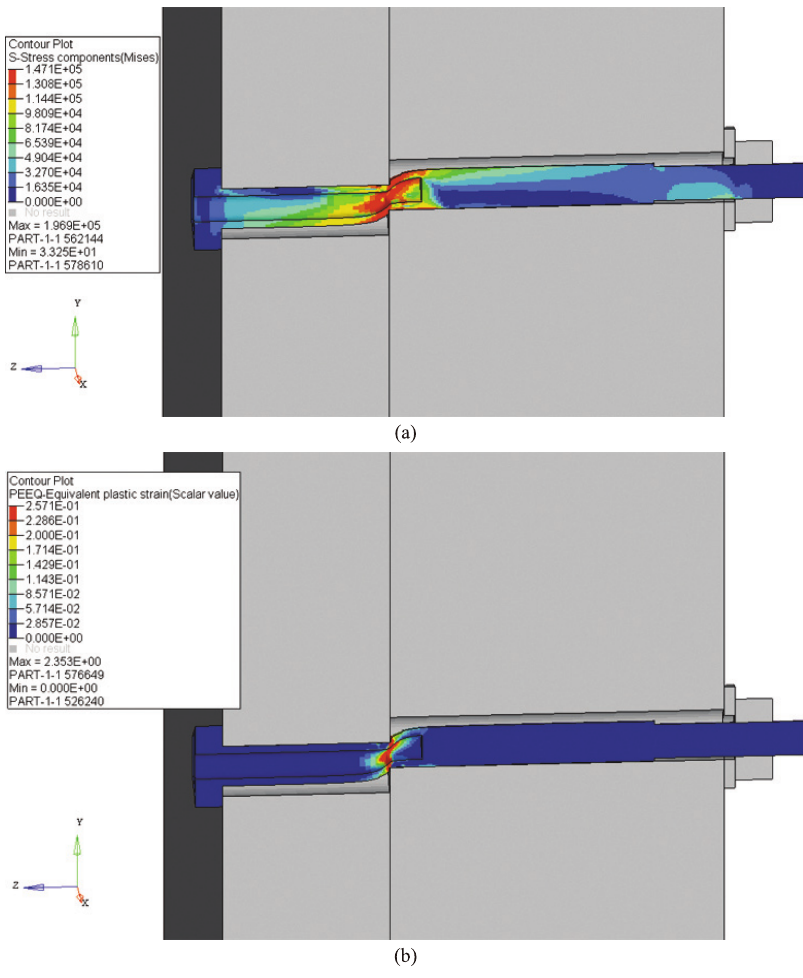
Fig. 11. Contours of (a) von Mises stresses and (b) equivalent plastic strain, at maximum applied displacement, static shear model.